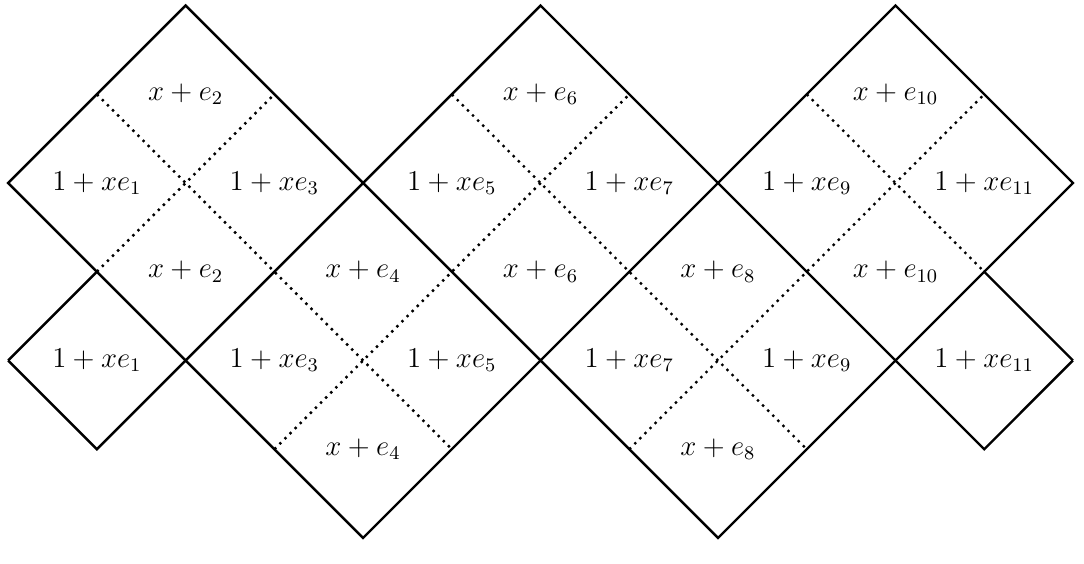
Figure 9 . The transfer matrix T defined in (3.37) with L = 6 , corresponding to the integrable transfer matrix in 5 evaluated at u 0